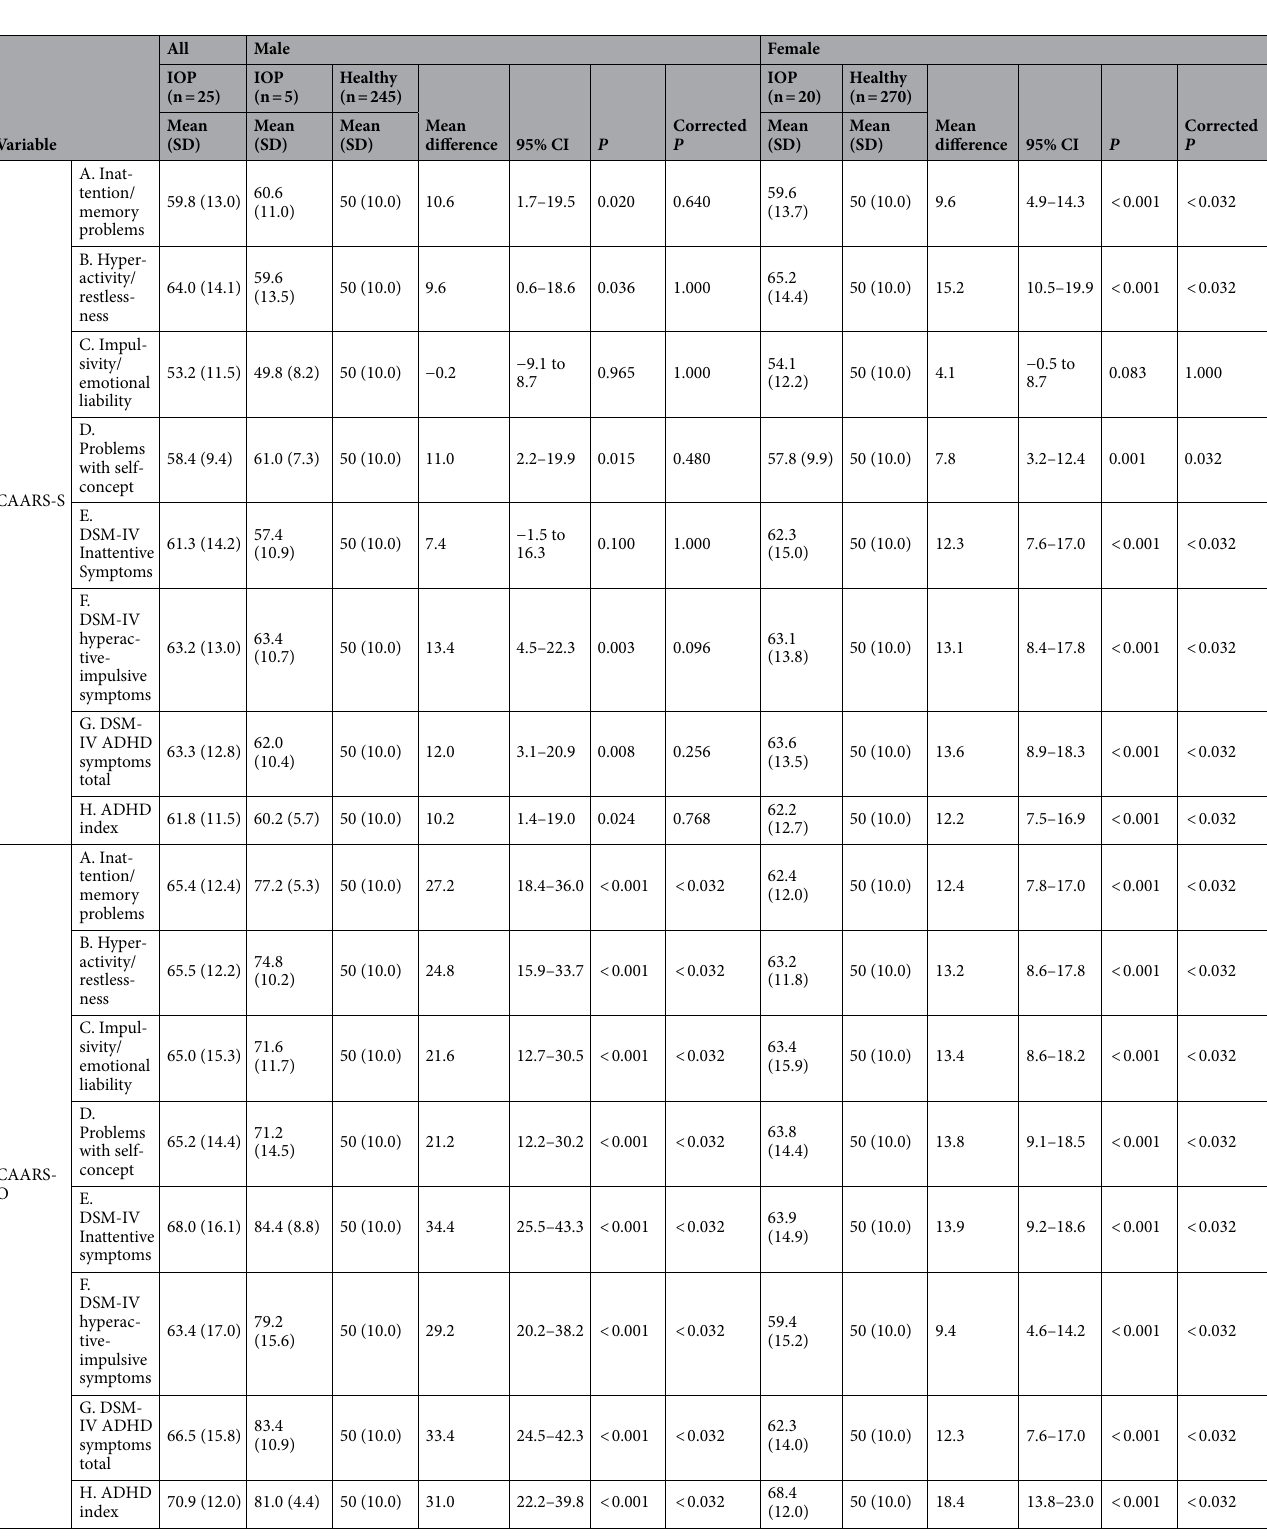
Table 2. Comparison of CAARS-S/O subscale scores between patients with persistent IOP and healthy controls. ADHD attention-deficit/hyperactivity disorder, CAARS-O Conners’ Adult ADHD Rating Scale standard deviation. P values were corrected by multiplying 32, the number of tests for multiple testing within the table and expressed as corrected p (i.e., Bonferroni